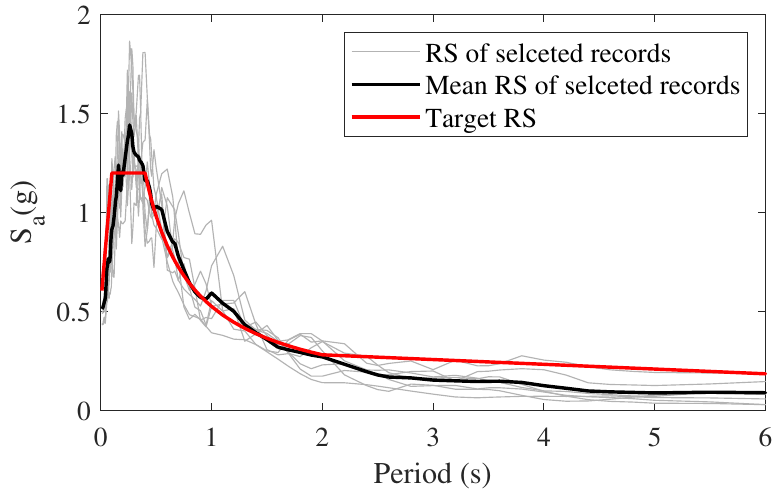
Figure 15. The acceleration response spectrum of the selected records Table 4. The information of the selected earthquake